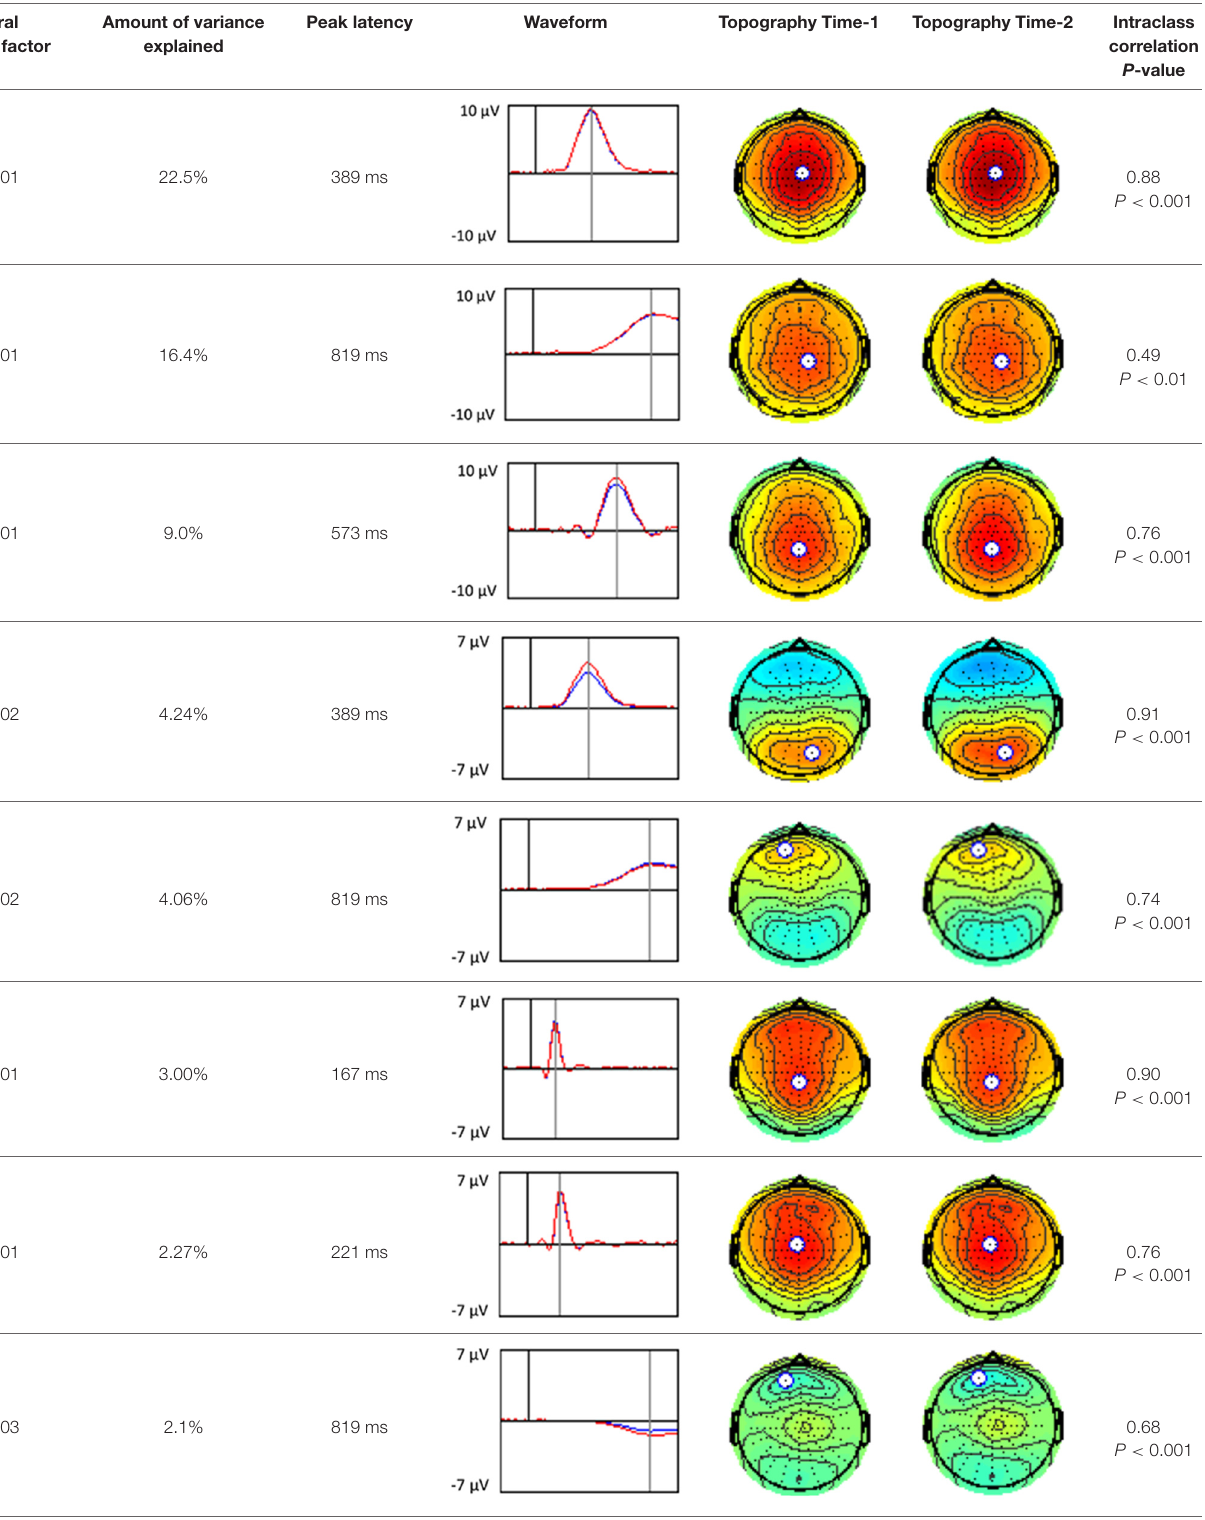
TABLE 2 | Temporospatial factors accounting for > 1% of